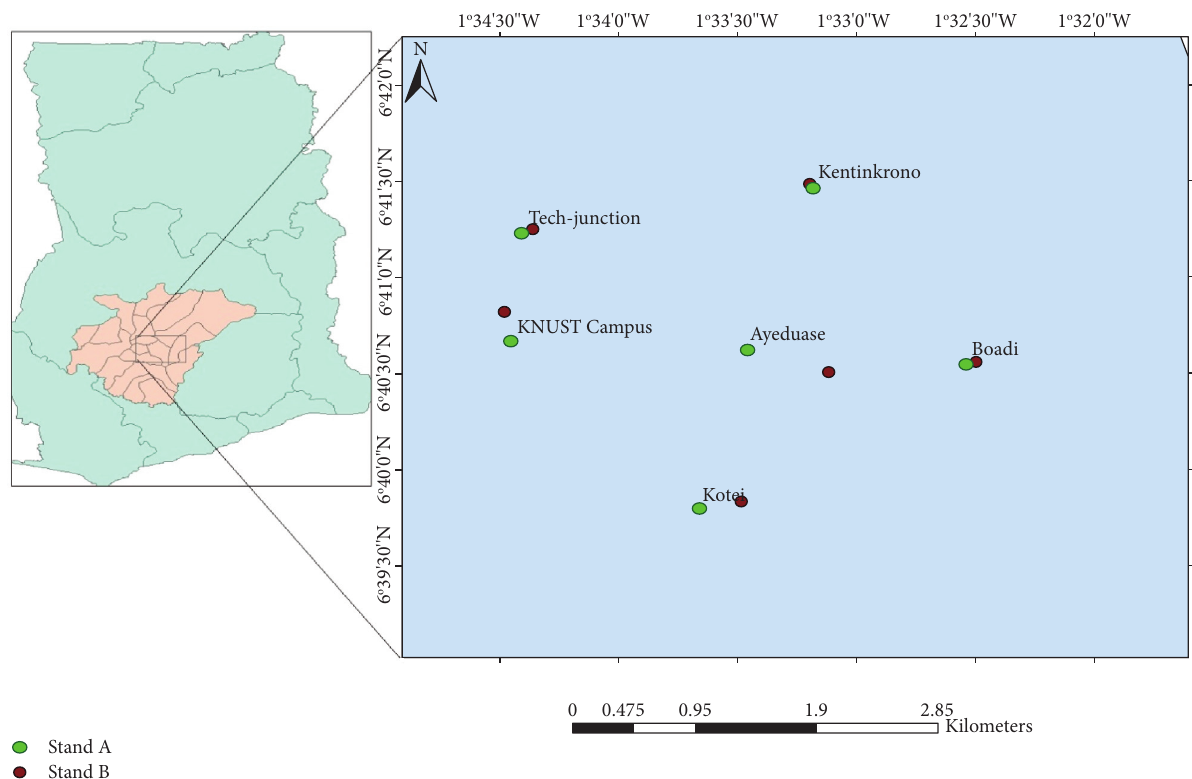
Figure 1: Map showing sampling